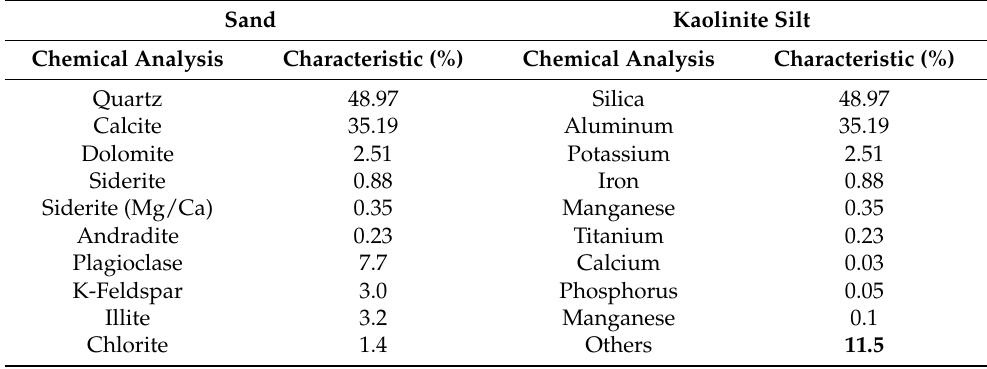
Table 2. XRD analysis of the used soil in this study.